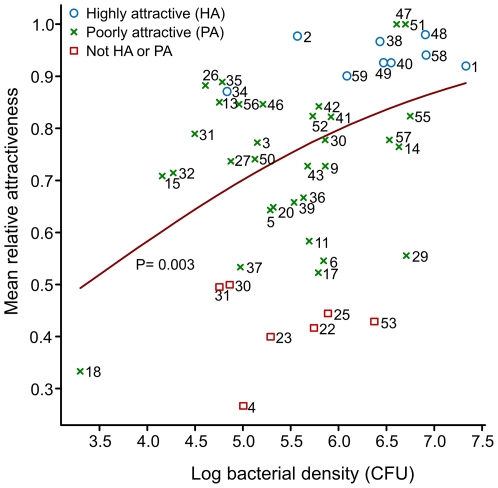
Skin bacterial abundance and relative attractiveness to An. gambiae.Correlation between the number of bacteria (log), determined by counts of colony forming units (CFUs) on non-selective plates and the relative attractiveness of the individuals. The relative attractiveness is expressed as the number of mosquitoes caught in the trapping device releasing the odour of the tested individual divided by the total number of mosquitoes trapped in both trapping devices [9]. The red line indicates the fitted relationship according to the Generalized Linear Model (GLM).